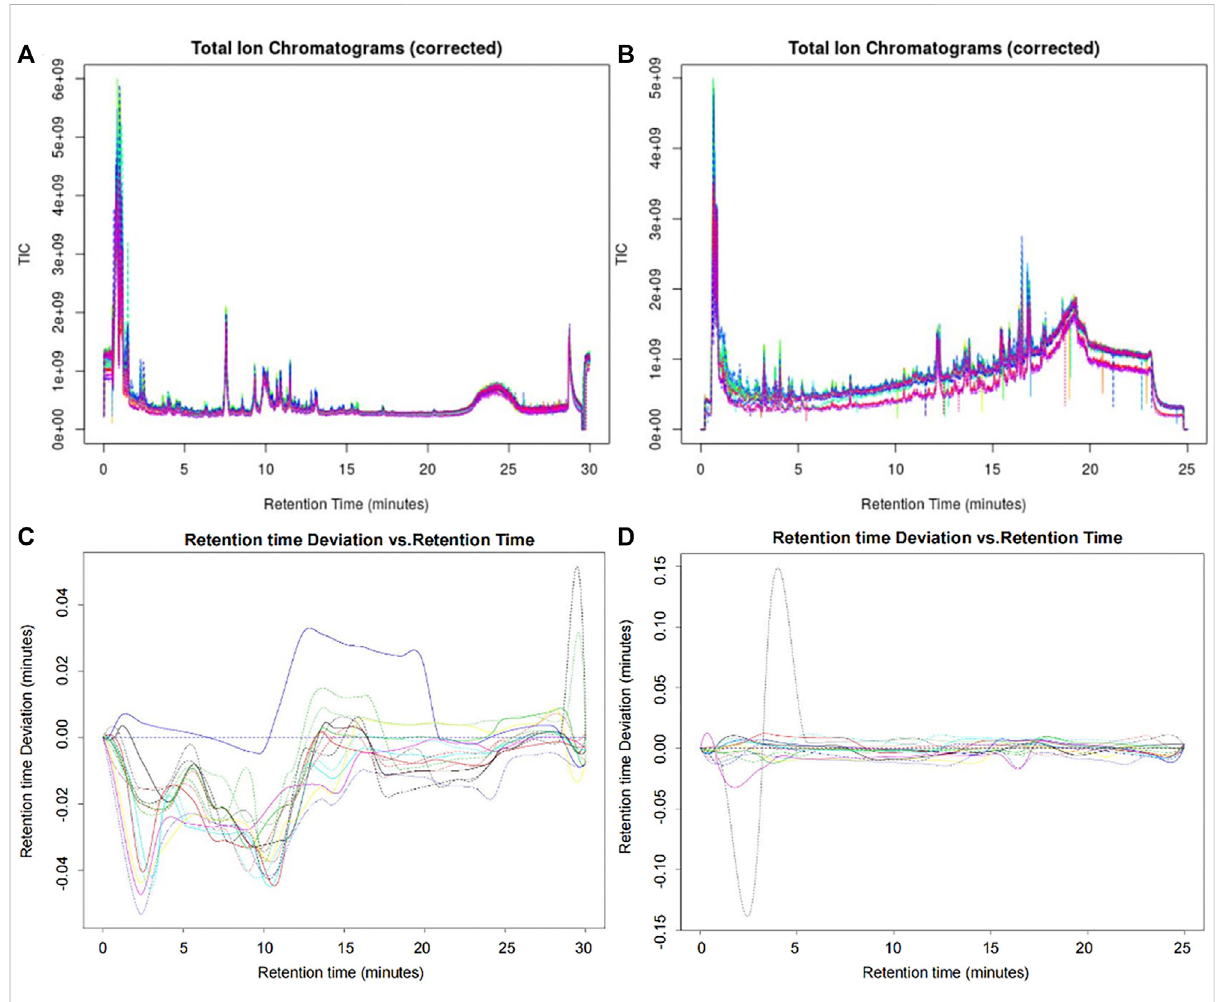
FIGURE 2 SuperpositionmapofthetotalionchromatogramsofAGsamples. (A) Correctedtotalionchromatograminthepositiveionmode; (B) corrected totalionchromatograminthenegativeionmode; (C) retentiontimedeviationdiagramoftheAGsamplesinthepositiveionmode; and (D) retention time deviation diagram of the AG samples in the negative ion